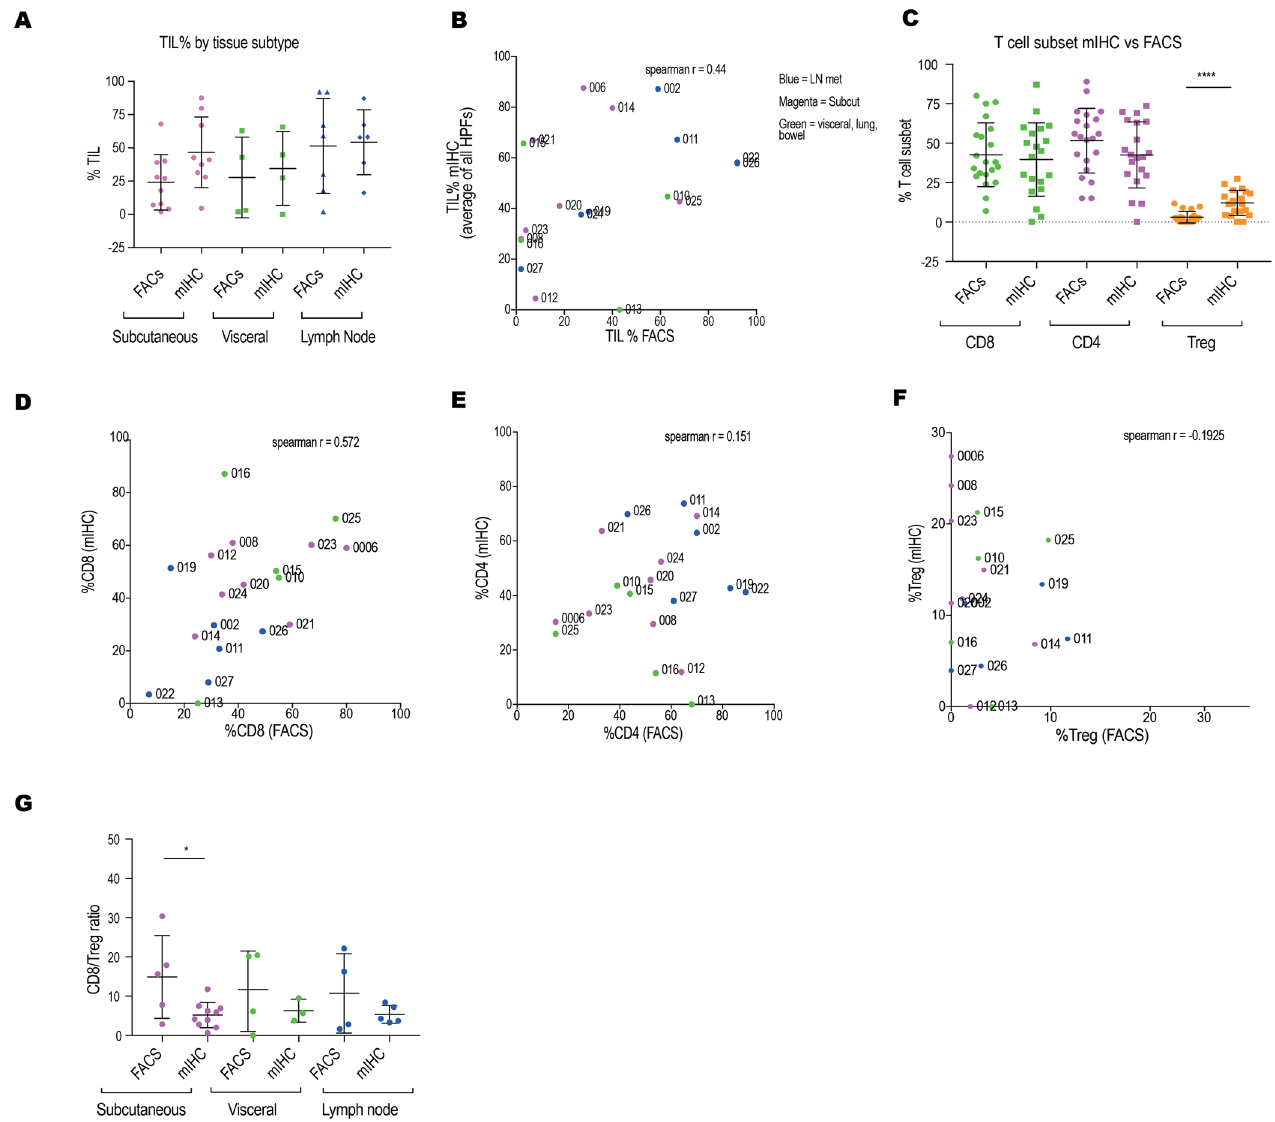
Figure 4. Melanoma stromal distribution of CD4 + T cells is a key factor for discrepant TIL data between mIHC and FACS. Melanoma metastases were analysed by FACS and mIHC (as per methods) and the T cell data compared. %TILs were measured by FACS as %(CD45 + HLA − ABC + ) of all viable cells (as depicted in Supplementary Fig. 6) and %TILs by mIHC as the %CD3 + DAPI + cells of total DAPI per HPF, and expressed as an average of multiple HPFs. Shown in ( A ) collated data for the cohort for %TILs measured via FACS vs mIHC, and divided into groups based on metastatic site; ( B ) a direct comparison of paired data for %TILs measured via FACS vs mIHC. Also, the % T cell subsets (CD8 + , CD4 + , Treg) measured by FACS vs mIHC in ( C ) for the whole cohort. A comparison of paired data (measured via FACS vs mIHC) in ( D ) %CD8 + T cells, ( E ) %CD4 + T cells, and ( F ) Treg. Finally CD8:Treg ratio was compared for mIHC vs FACS and grouped according to tissue origin ( G ). Statistical analysis (Mann Whitney) was performed across the cohort comparing mIHC and FACS data, significantly different data is represented by * (p < 0.05) and **** (p < 0.001). Also a Spearman correlative analysis was performed for ( B ) and ( D – F ), the r value is provided in each